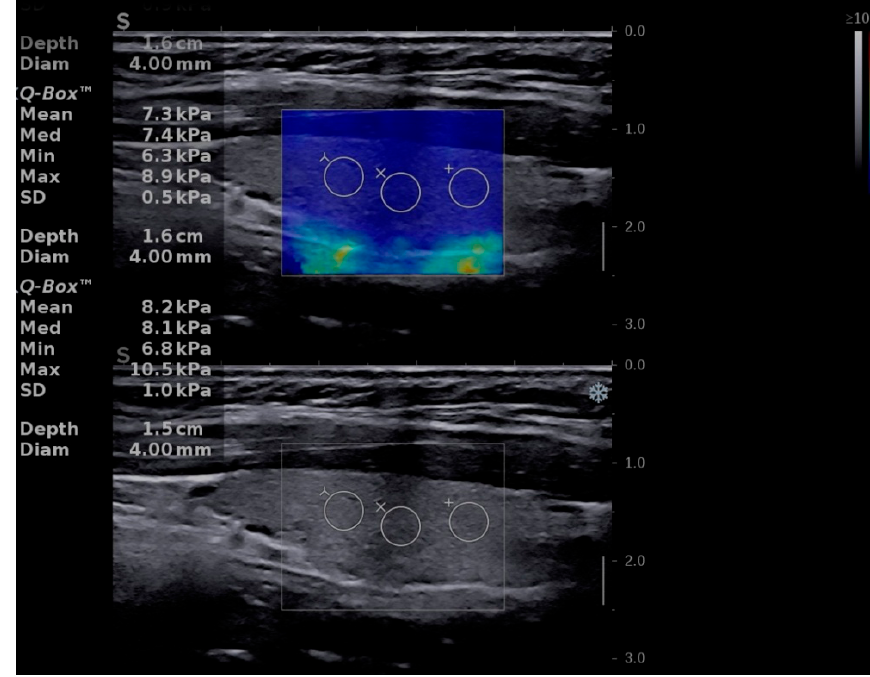
Figure 1. Shear-wave elastography of a healthy child, boy, 13 years old.